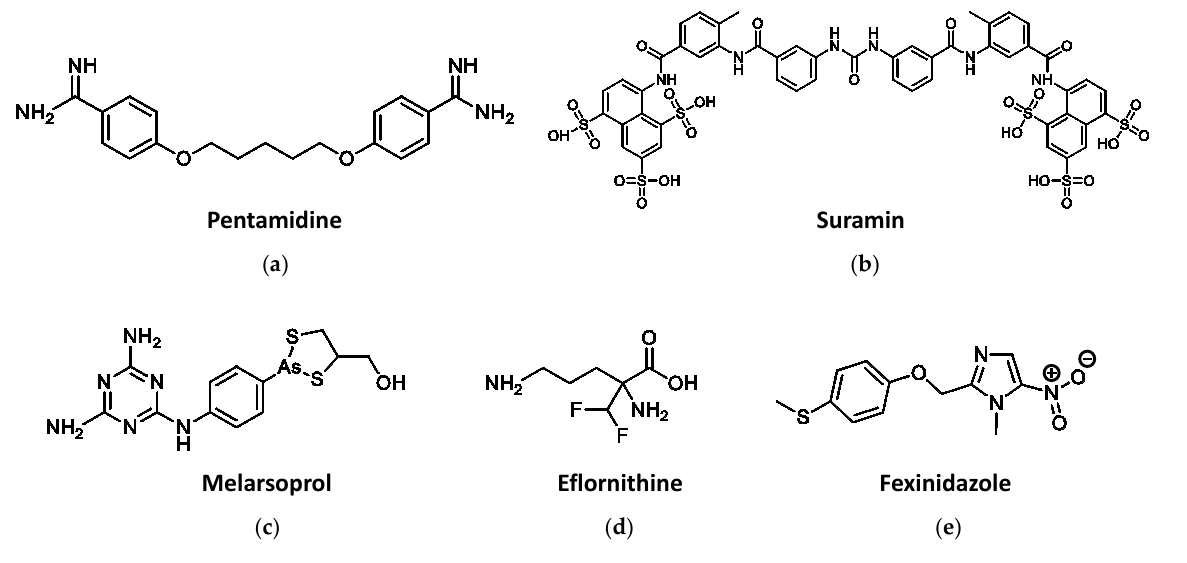
Figure 2. Drugs in clinical use against Human African Trypanosomiasis (HAT). ( a ) Pentamidine. ( b ) Suramin. ( c ) Melarsoprol. ( d ) Eflornithine. ( e ) Fexinidazole.